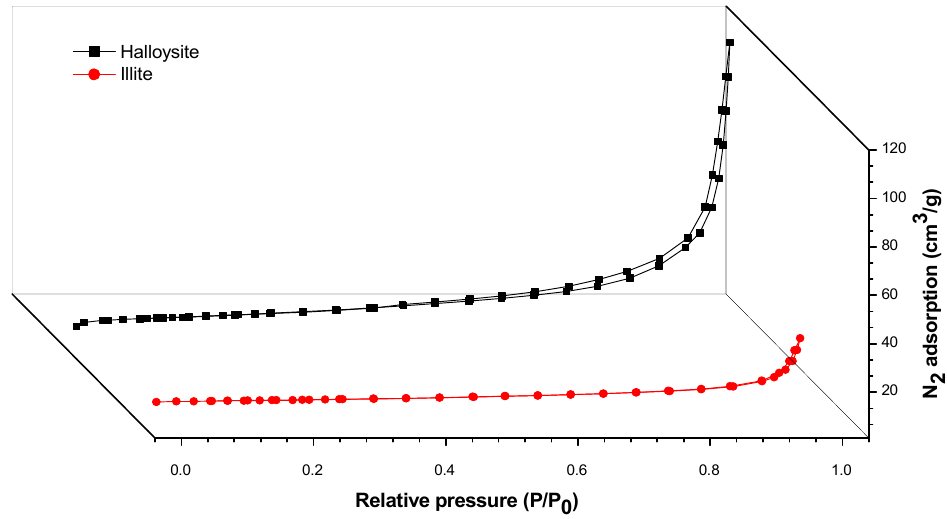
Figure 3. Zeta potential of halloysite and illite as a function of pH.